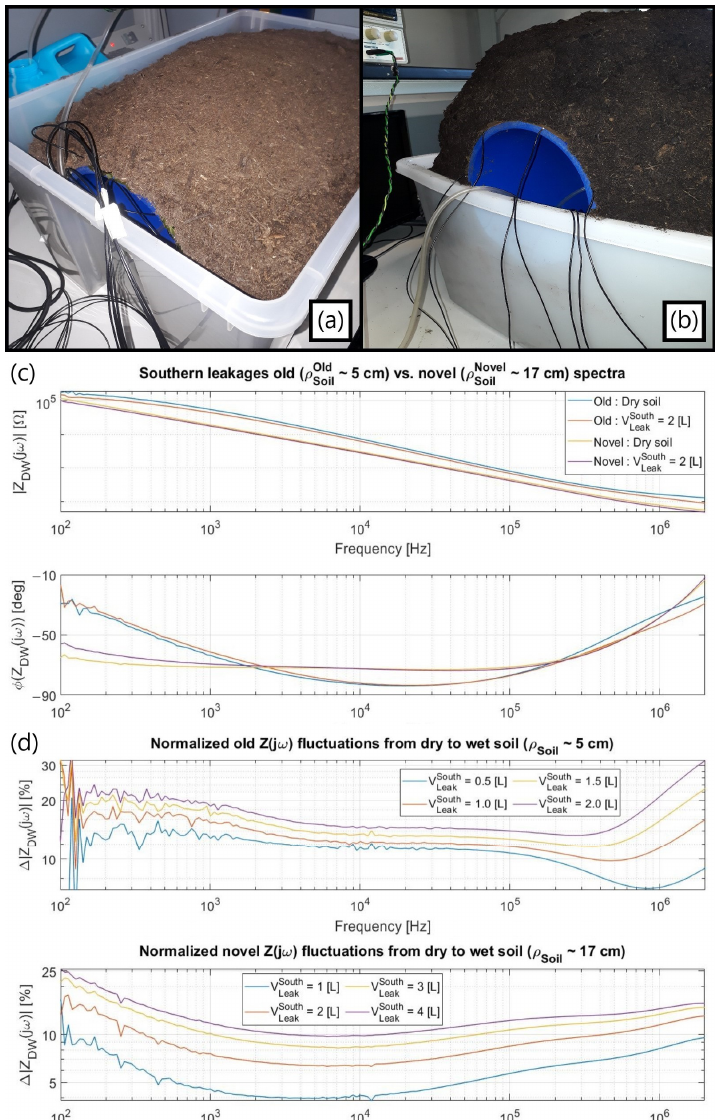
Figure 11. ( a ) First shallower terrain thickness of about 5 cm tested with the single-ended approach; ( b ) Deeper soil radius of around 17 cm, ensuring the ρ Soil > 3G principle from Section 3.1.2. Its darker color is caused by accumulated background humidity; ( c ) Comparison between the dry-to-wet impedance spectra, namely Z DW (j ω ), in both cases; ( d ) Absolute impedance variations for increasing water volumes dispersed within setups normalized by their dry baselines.